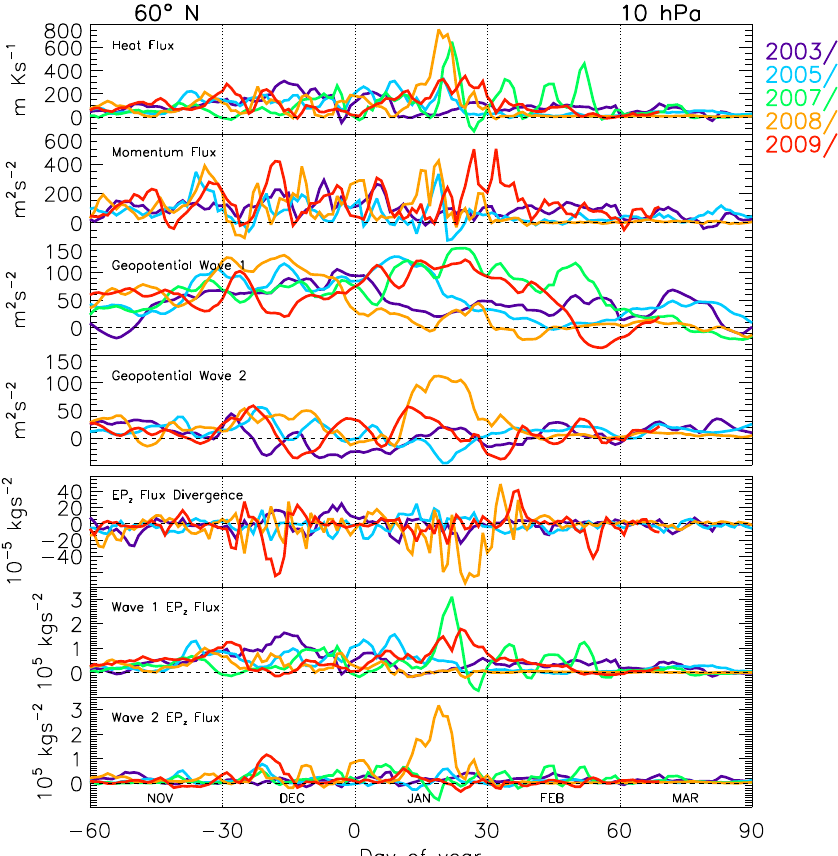
Fig. 3. Temporal evolution of various zonally averaged derived quantities (data: the ECMWF operational analysis) for selected Arctic winters at 10hPa and 60 ◦ N. The quantity zero is marked with dashed horizontal lines. Since the warming was not severe in 2007/08, some entities are not shown for this winter for clarity reasons. The dotted vertical lines represent the month boundaries.